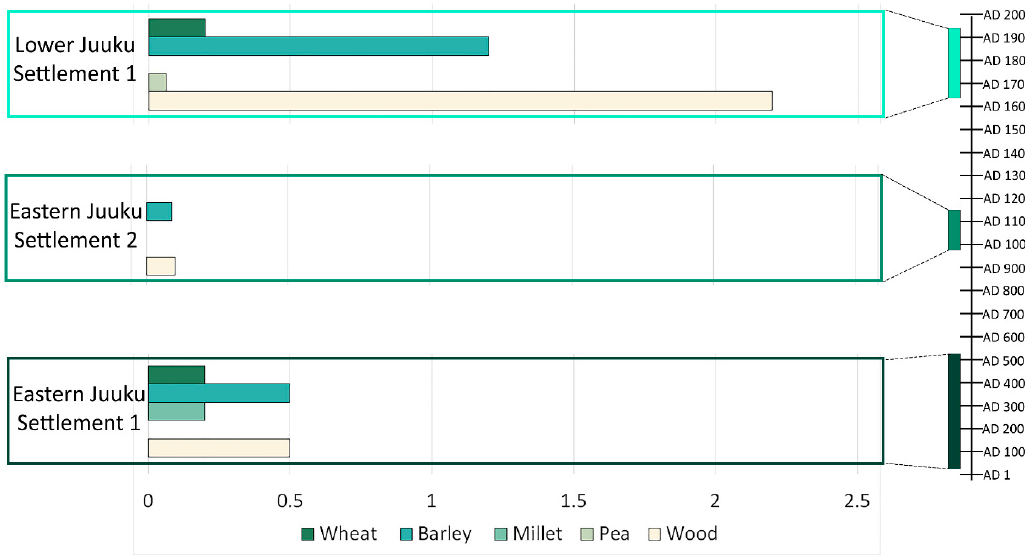
Figure 7. Cultivated crop and wood density from three sites at the Juuku Valley.